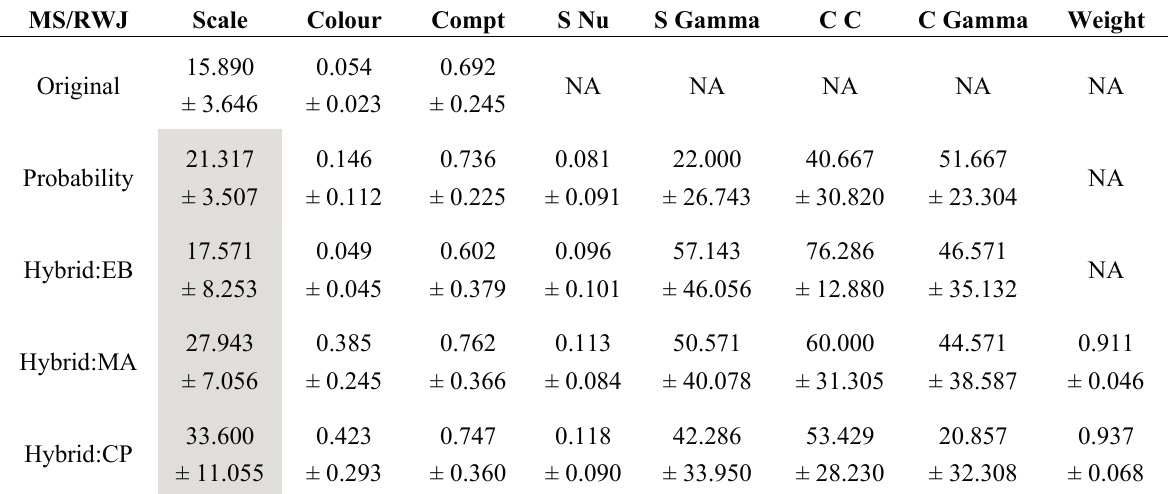
Table 8. Parameters generated for the Jowhaar problem instance.